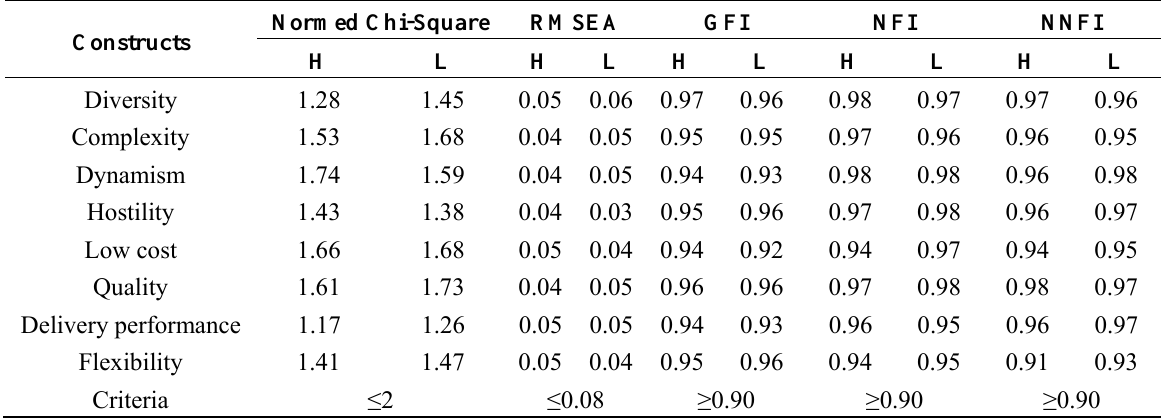
Table A2. Goodness-of-Fit Indices for the Measurement Models.